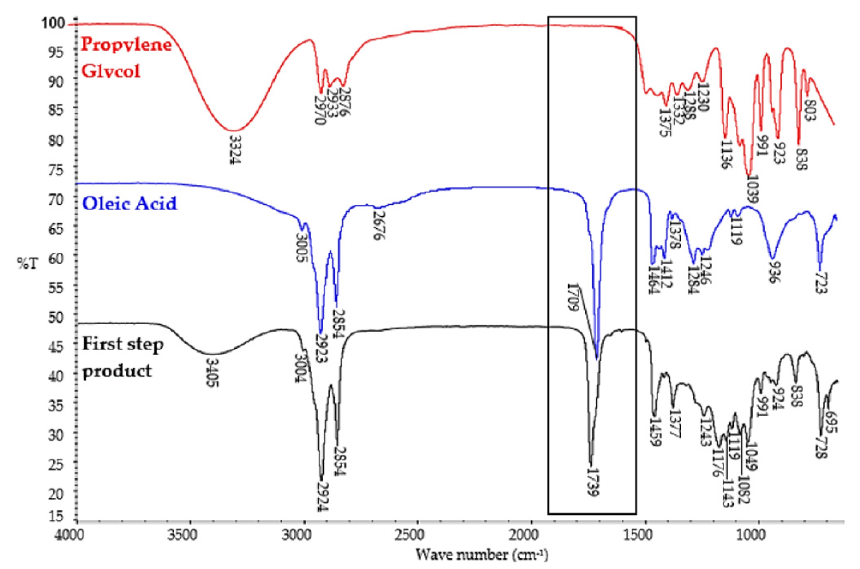
Figure 2. FT–IR spectra of raw materials (propylene glycol and oleic acid) and the first-step product.